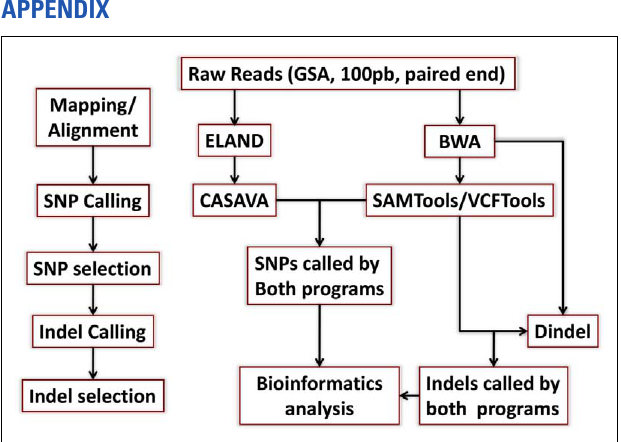
FIGUREA1 | Schematic of the mapping/alignment and variant calling steps. We used the Eland and BWA aligners to map reads to the reference genome, and CASAVA and SAMTools to call SNPs as explained in Section “Materials and Methods.” Short insertion and deletions were called using SAMTools and Dindel. Only variants that were called by both algorithms and passed quality control filters were included in the follow-up analyses.